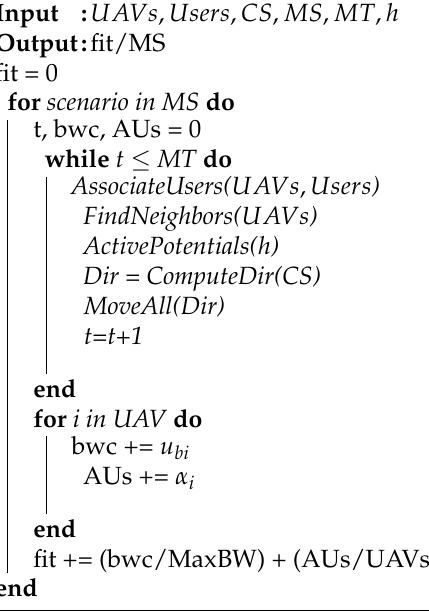
Algorithm 2 Genetic Adaptive Network Deployment